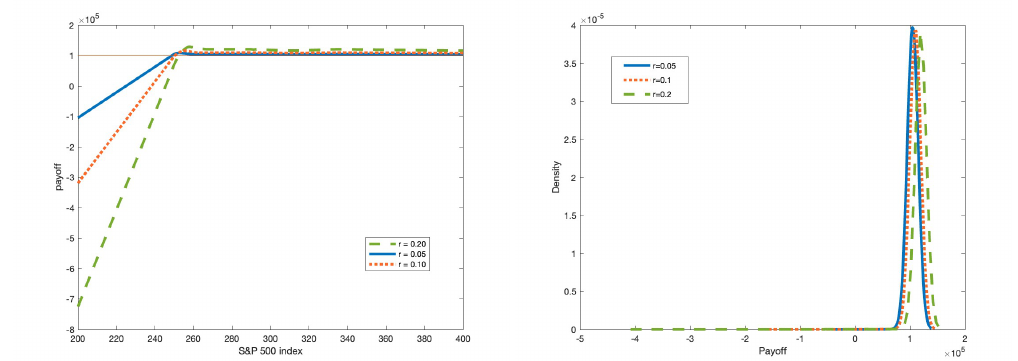
Figure 5. The minimum standard deviation of the portfolio payout distribution with r = 0.2,0.1,0.05 ( left ), the kernel density estimation of the portfolio payout with r = 0.2,0.1,0.05 ( right ).